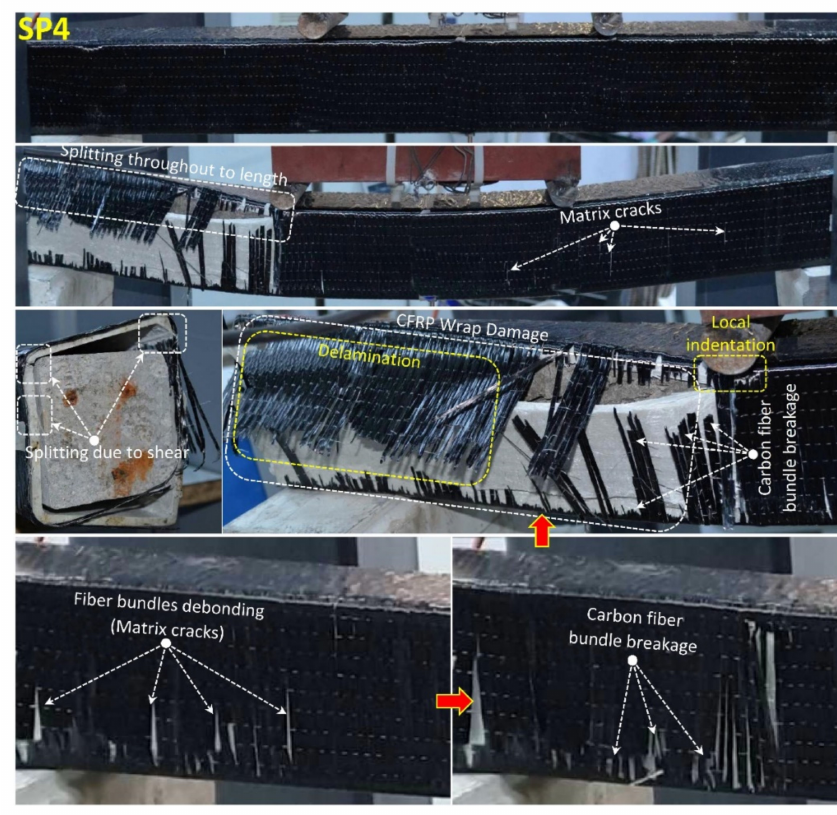
Figure 13. Undamaged and damaged specimen images of